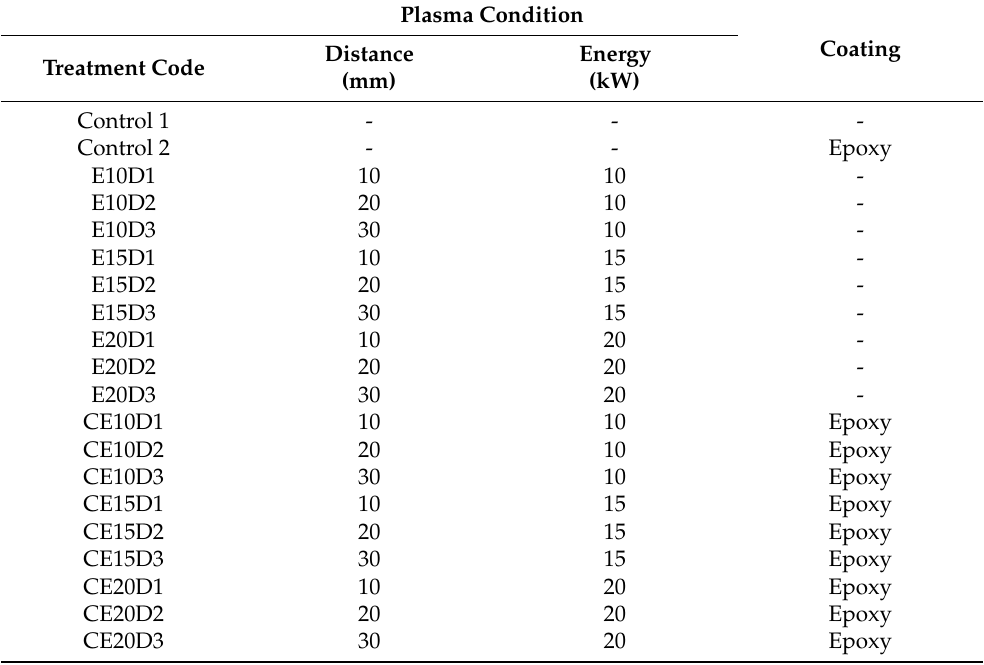
Table 1. Surface treatment of the PB and MDF composite panels. Sample codes refer to the coating type and plasma condition (distance from the nozzle and plasma energy).